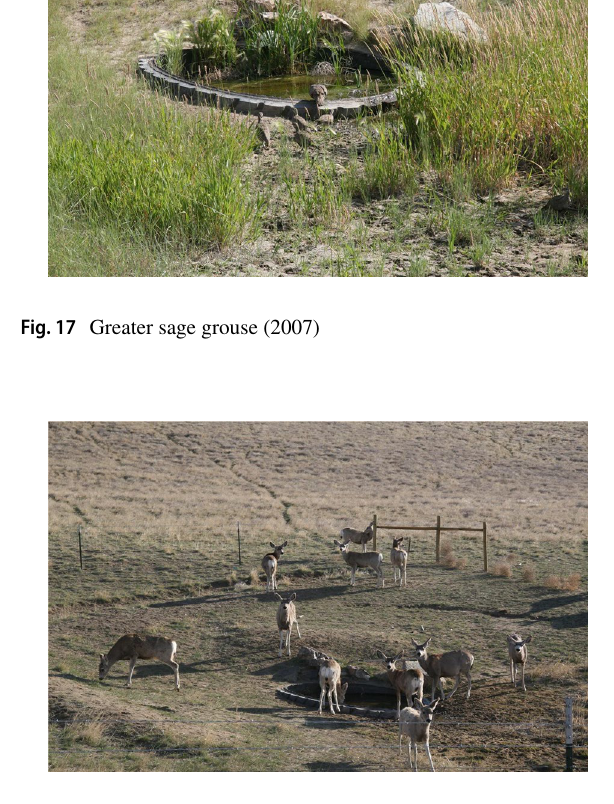
Fig. 18 Mule deer on a reclaimed site (2007)